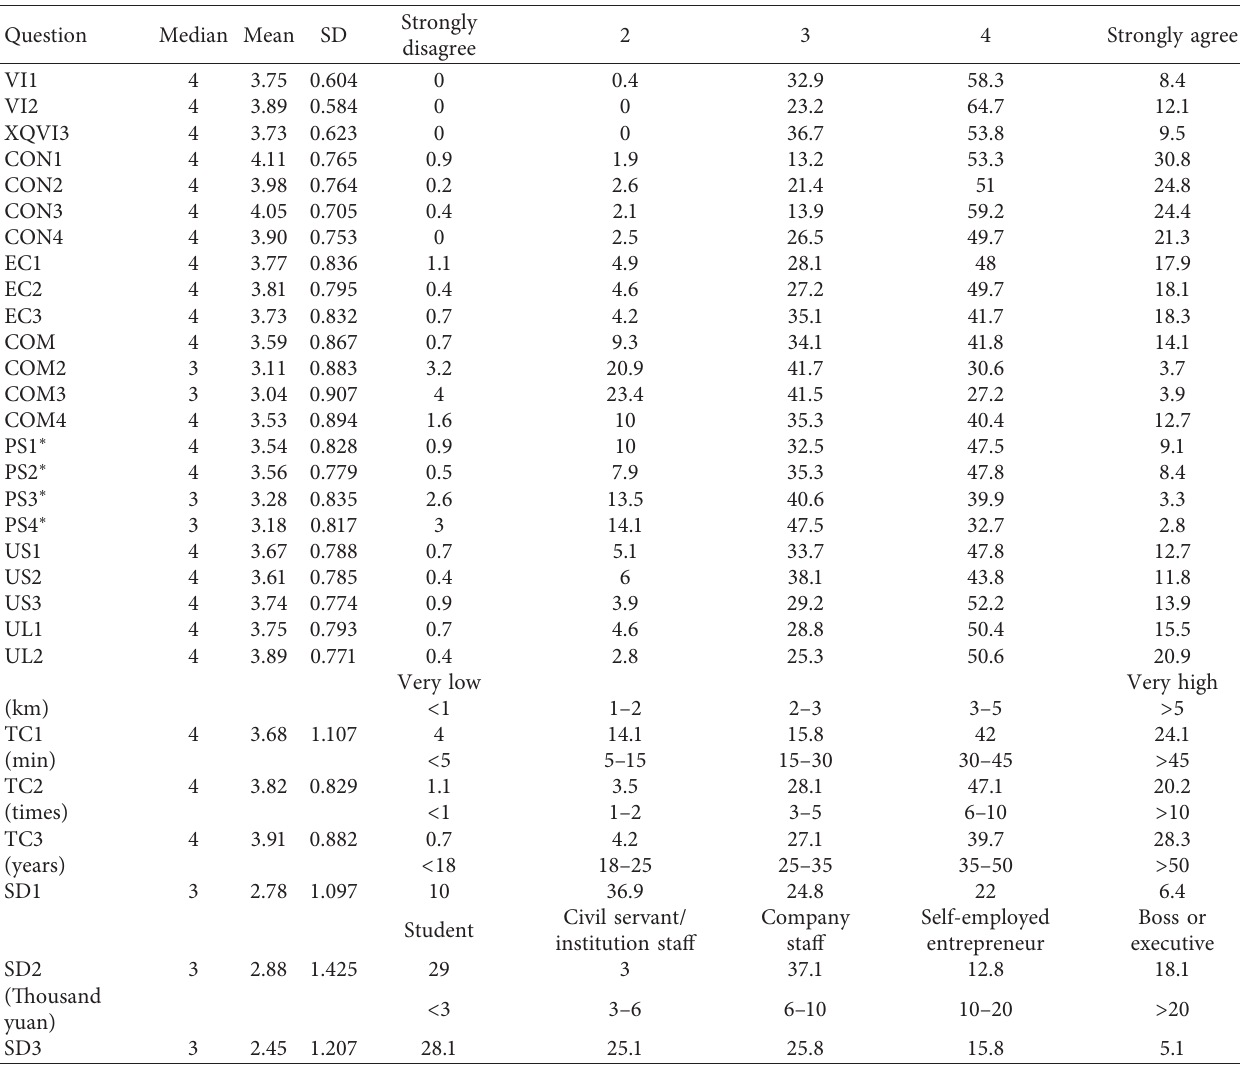
Table 3: Descriptive statistics for indicators of model